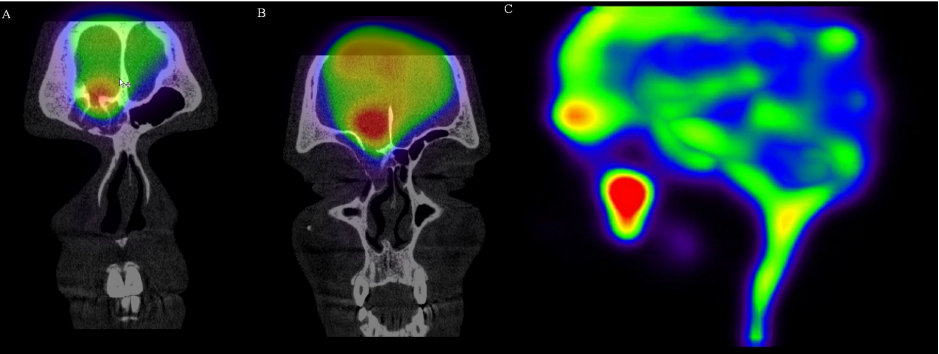
Figure 4. SPECT scanning: ( A ) coronal image of increased radioisotope activity over the right frontal sinus with bone defect; ( B ) coronal image of increased radioisotope activity over the anterior part cribriform plate with bone defect; ( C ) SPECT scan showing increased activity in the frontal area and the cumulation of radioisotope in the right maxillary sinus. (Images provided with the courtesy of the Institute on Nuclear and Molecular Medicine,